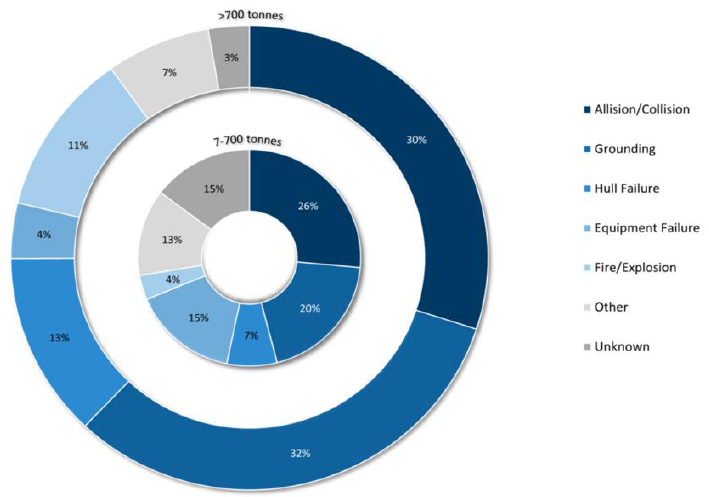
Figure 1 . Tanker spills per decade, 1970 – 2021. Reproduced with permission from ITOPF, 2022 [7]. Figure 1. Tanker spills per decade, 1970–2021. Reproduced with permission from ITOPF, 2022 [7].